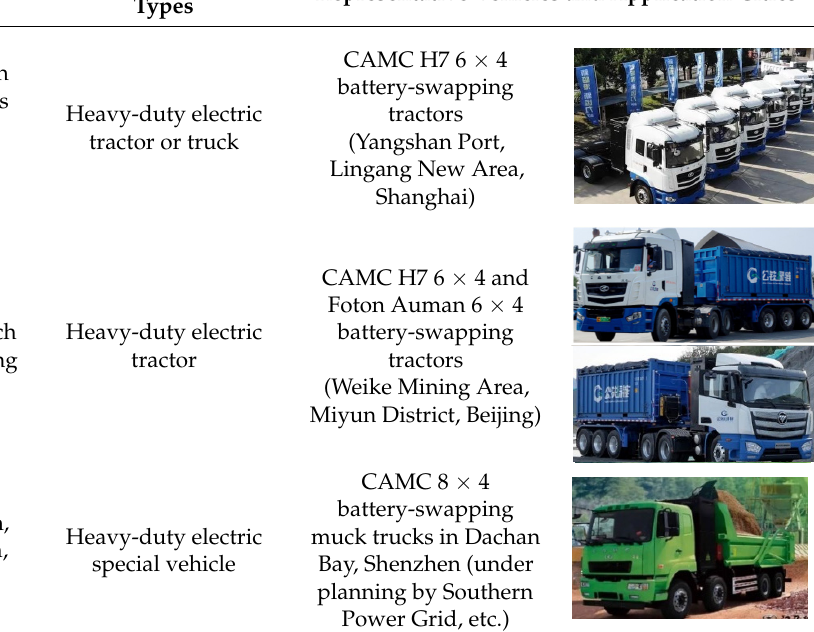
Table 1. Main vehicle types and application scenarios of BS-HDT.